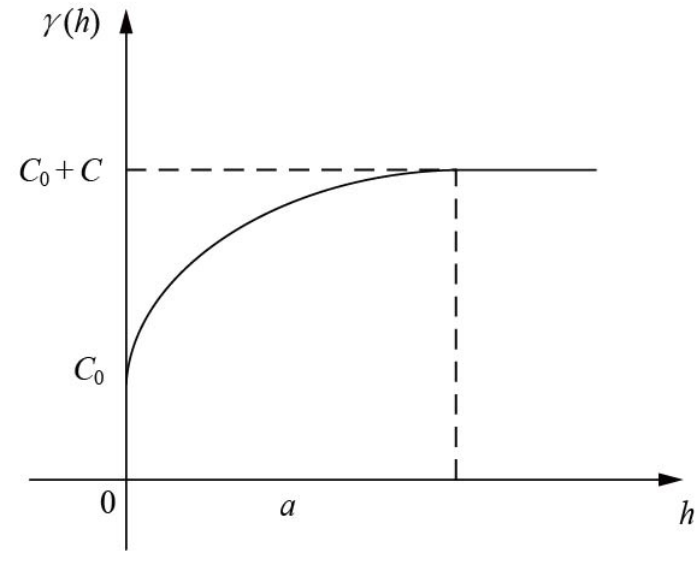
Figure 2. Graph of covariance function.